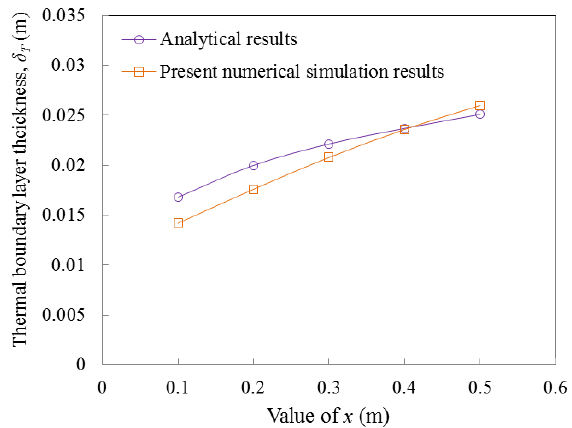
Figure 9. Comparison of numerical and analytical boundary layer thickness for methane